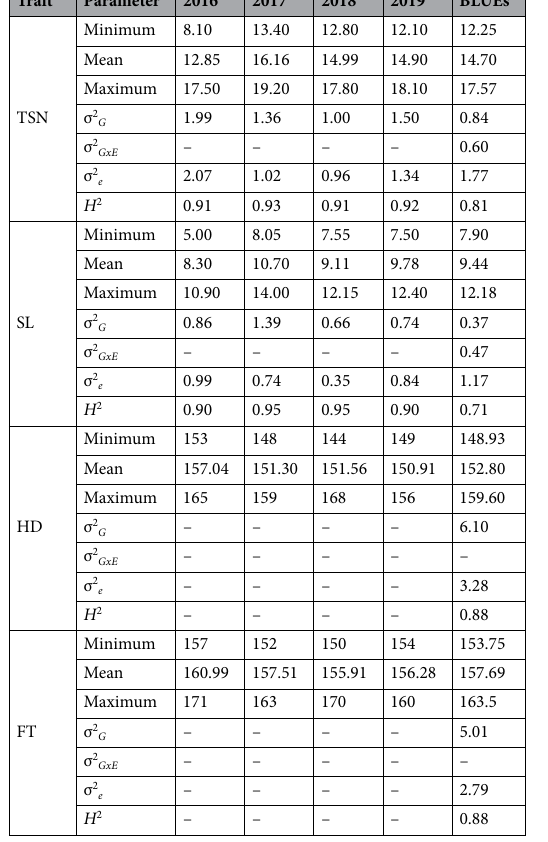
Table 1. Summary statistics for total spikelet number (TSN), spike length (SL), heading date (HD), and flowering time (FT) across 4 years and their corresponding best linear unbiased estimations (BLUEs). σ 2 G genotypic variance, σ 2 GxE genotype-by-environment variance, σ 2 e residual variance, H 2 repeatability among replicates (single years) or broad-sense heritability